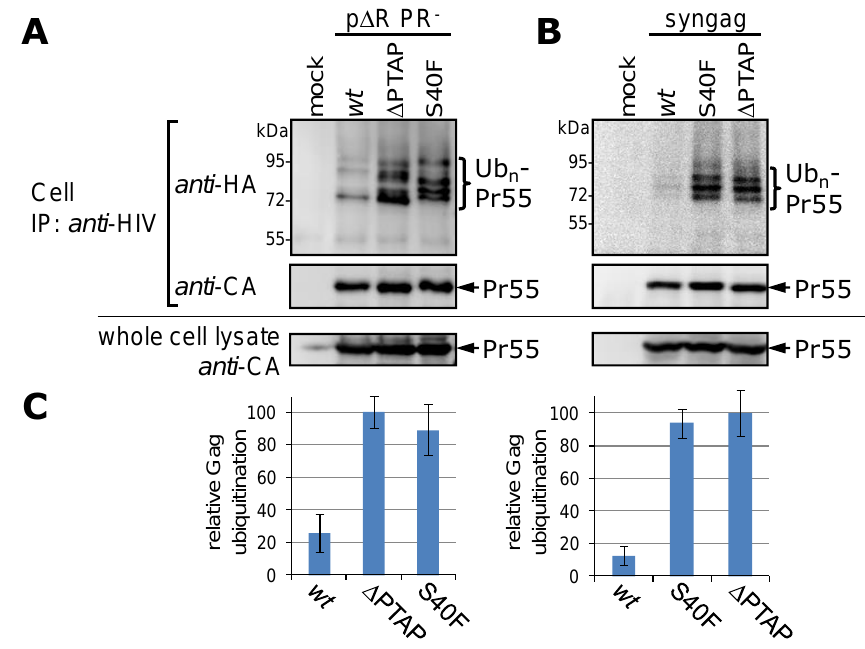
Figure 2. The S40F mediated ubiquitination of Gag occurs irrespective of Gag processing or other viral proteins. HeLa cells were co-transfected with HA-ubiquitin and either p∆R PR − plasmids ( A ) or syngag plasmids encoding for either wt Gag, or the p6 mutant S40F or ∆PTAP, respectively ( B ). Gag was recovered by immunoprecipitation from